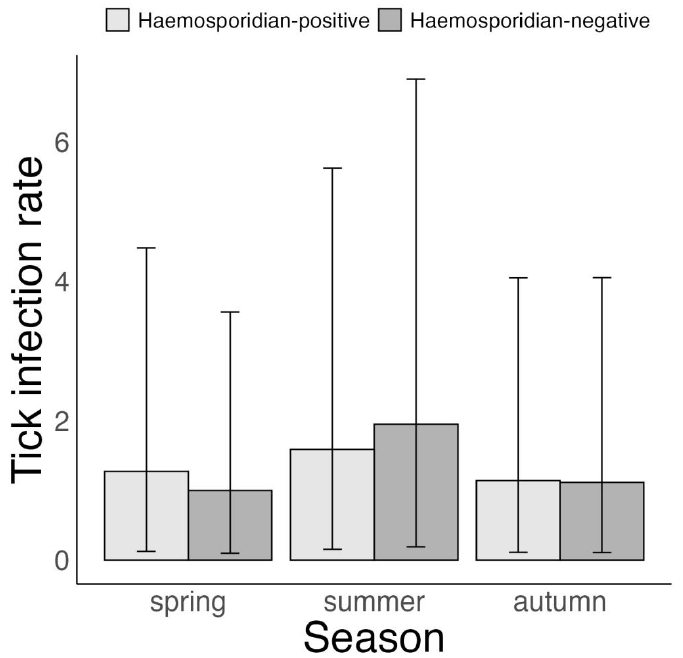
Figure 5. Bayesian zero inflated negative binomial model on variation in the rate of Borrelia -infected bird-feeding Ixodes ricinus ticks per host according to haemosporidian infection status of 4 avian host species in Slovakia, 2017 – 2019. The plotted rates are shown relative to the average tick infestation of 5.5 ticks per host. Displayed are posterior means and 95% CrI. Considering the summer – autumn period and assigning birds to HY and AHY age classes, the tick infection rate relative to the average infestation intensity (4.70 ticks), tended to be 0.4 ticks lower in haemosporidian-positive compared to haemosporidian- negative hosts (haemosporidian-positive vs. haemosporidian-negative hosts: – 0.4 ticks ( – 1.36 to 0.16), p = 0.89). Importantly, this trend only holds for the group of AHY birds (haemosporidian-positive vs. haemosporidian-negative hosts — AHY birds: – 0.63 ticks ( – 2.02 to 0), p = 0.95 and HY birds: – 0.08 ticks ( – 0.54 to 0.28), p = 0.62, Figure 6 and Table S6).